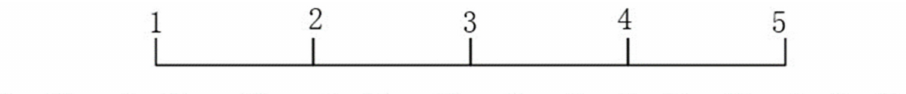
Figure 4. Subjective evaluation scale.